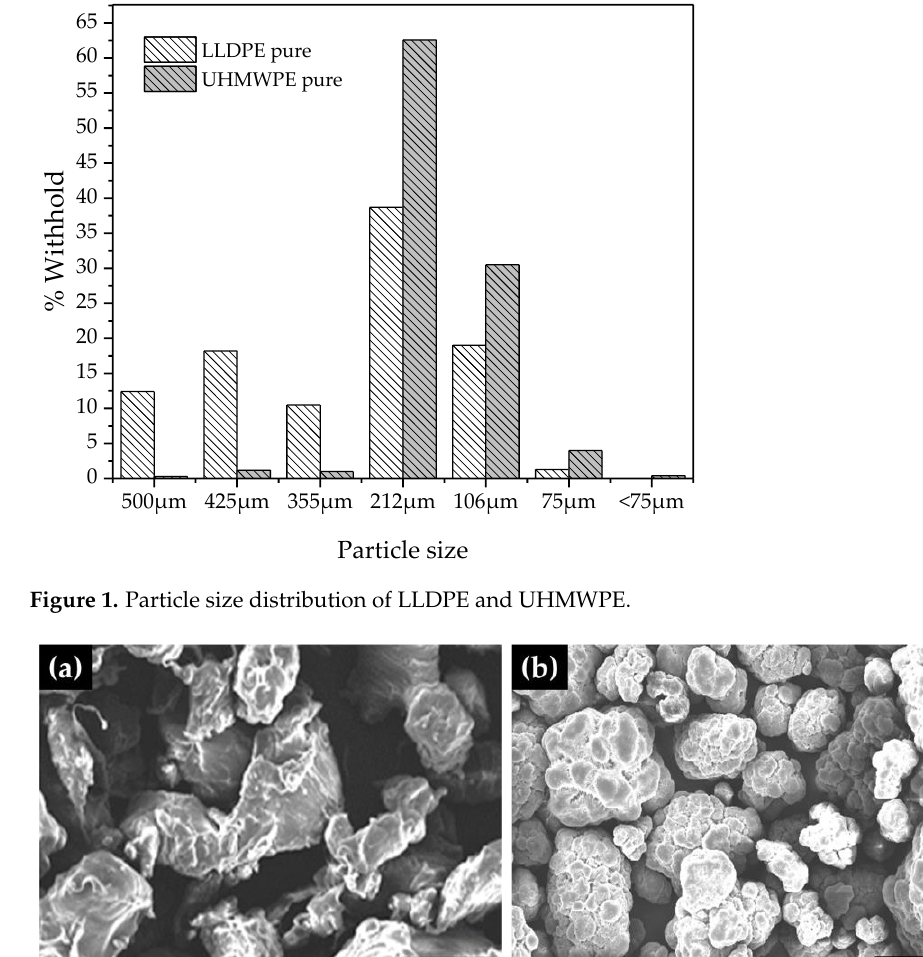
Figure 2. SEM images of pure polymer powders: ( a ) LLDPE, ( b ) UHMWPE.